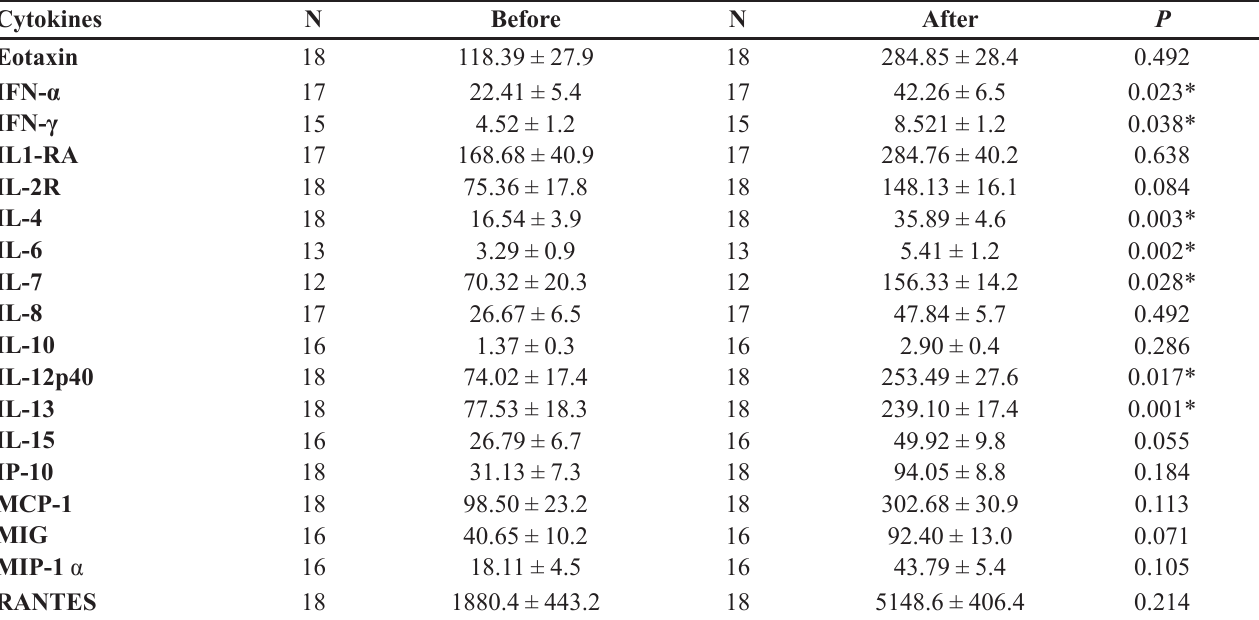
TABLE III - Serum cytokines levels (pg/mL) of diabetic patients before and after supplementation with glutamine dipeptide. N = number of patients